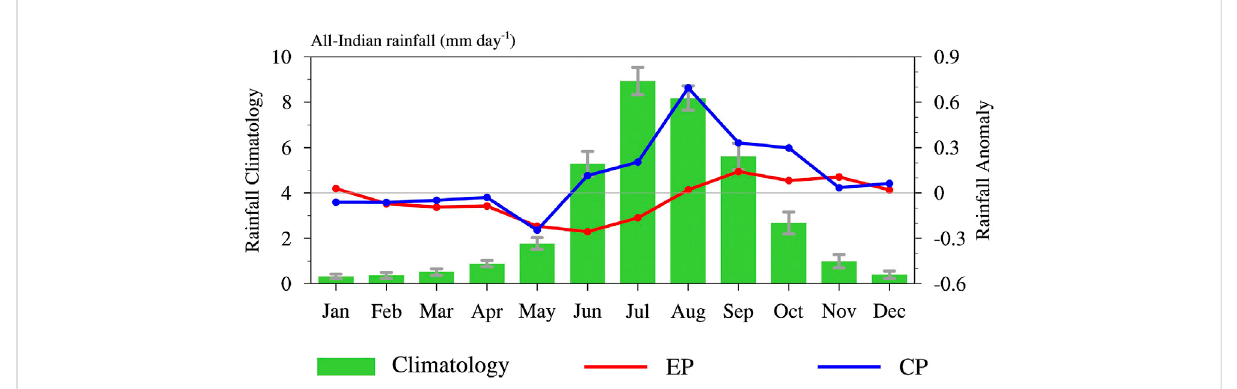
FIGURE 2 Climatology (1951 – 2016) of the all-India monthly rainfall (green bars; units: mm day − 1 ) and the anomalies (units: mm day − 1 ) of the all-India monthlyrainfallduringthedecayingyearsofEPElNiñoevents(red)andCPElNiñoevents(blue).Thegrayerrorbarsindicateonestandarddeviation.